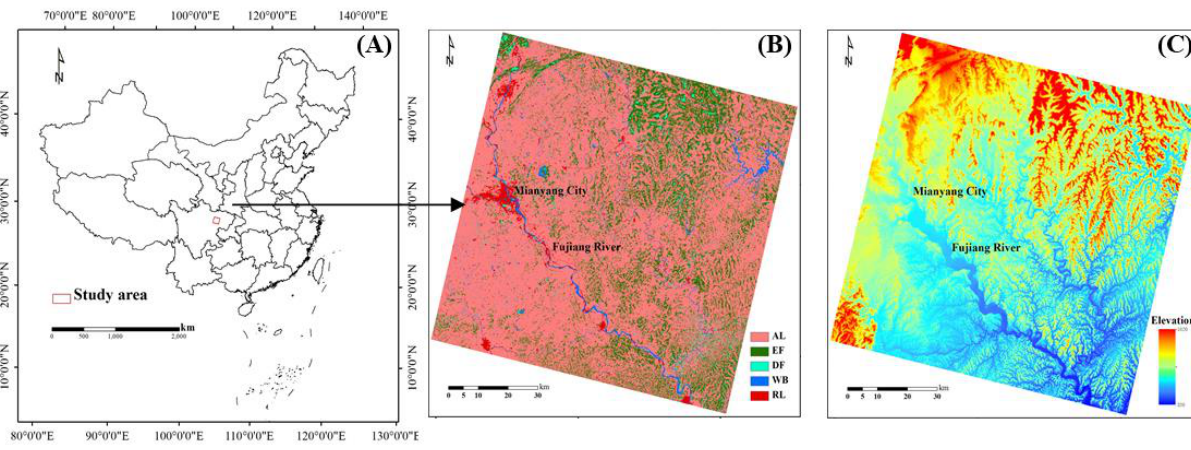
Figure 1. ( A ) Location of the study area; ( B ) Land cover map of the study area; the abbreviation in the legend is defined as AL (arable lands), EF (evergreen forests), DF (deciduous forests), WB (water bodies), and RL (residential lands); ( C ) DEM of study area showing the terrain